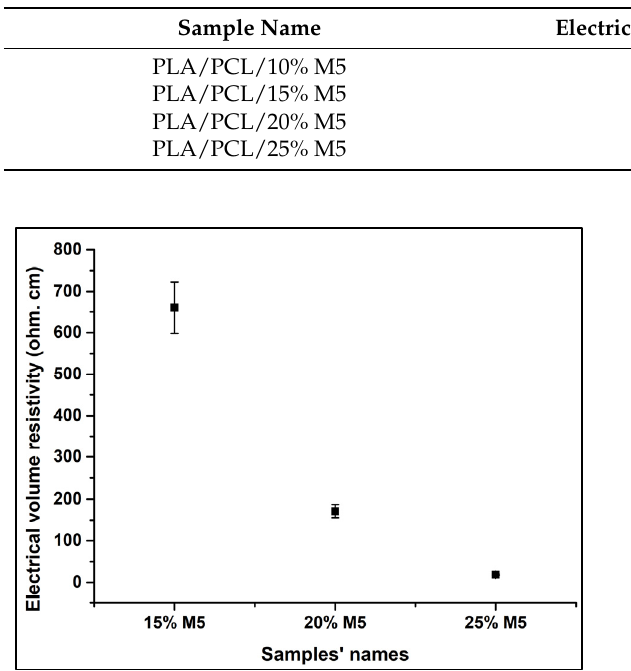
Figure 15. The variation of the electrical volume resistivity of the composites as a function of the percentage of M5 GNP.